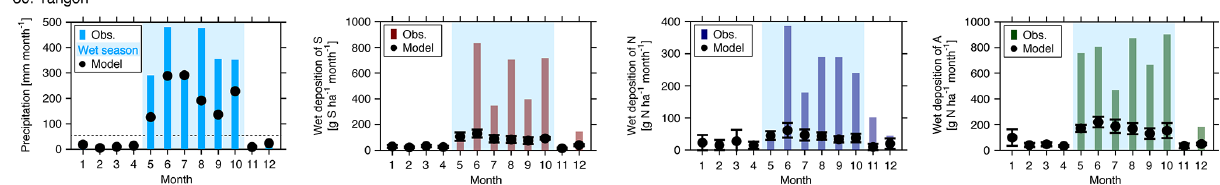
Figure 2. Monthly accumulated precipitation and wet depositions of S, N, and A in Yangon, Myanmar. Whiskers represent the standard deviation among the seven models, and the wet season (light blue color) is defined as months when precipitation exceeded 50mm. Table 3. Statistical analysis of the model performance for Yangon,